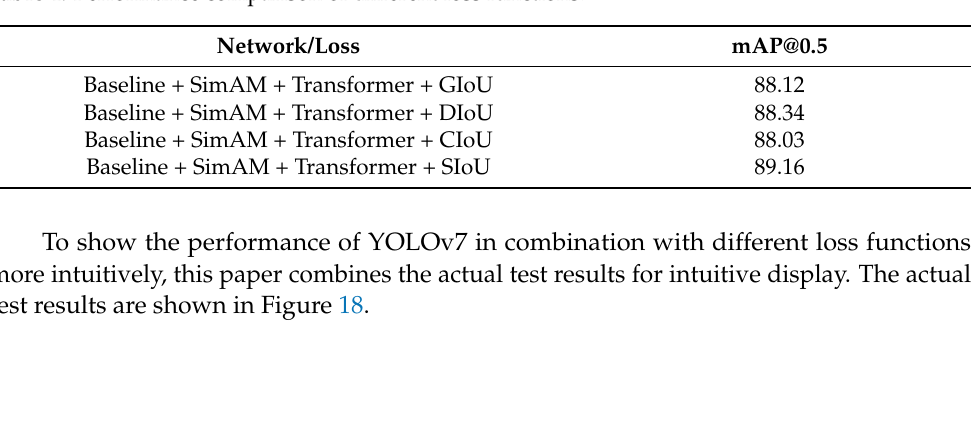
Table 4. Performance comparison of different loss